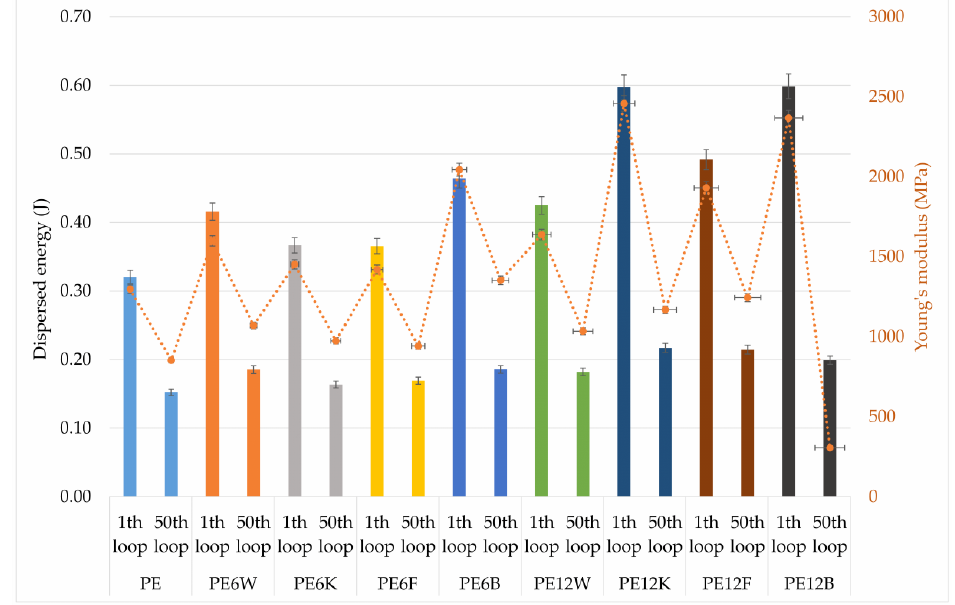
Figure 7. Relation of dispersed energy and Young modulus obtained in first and fiftieth hysteresis loop.